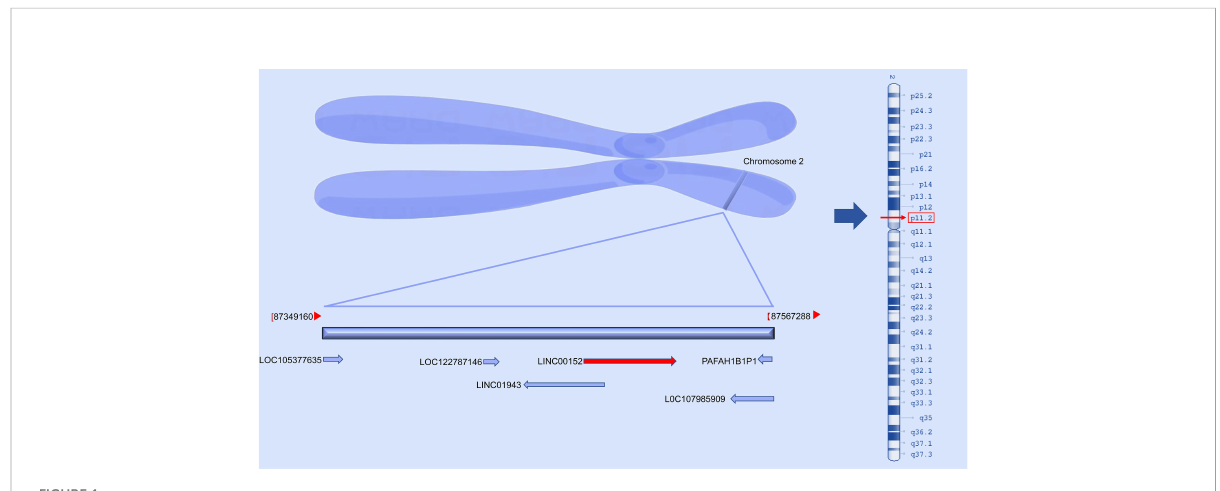
FIGURE 1 Location of LINC00152 in chromosomal region